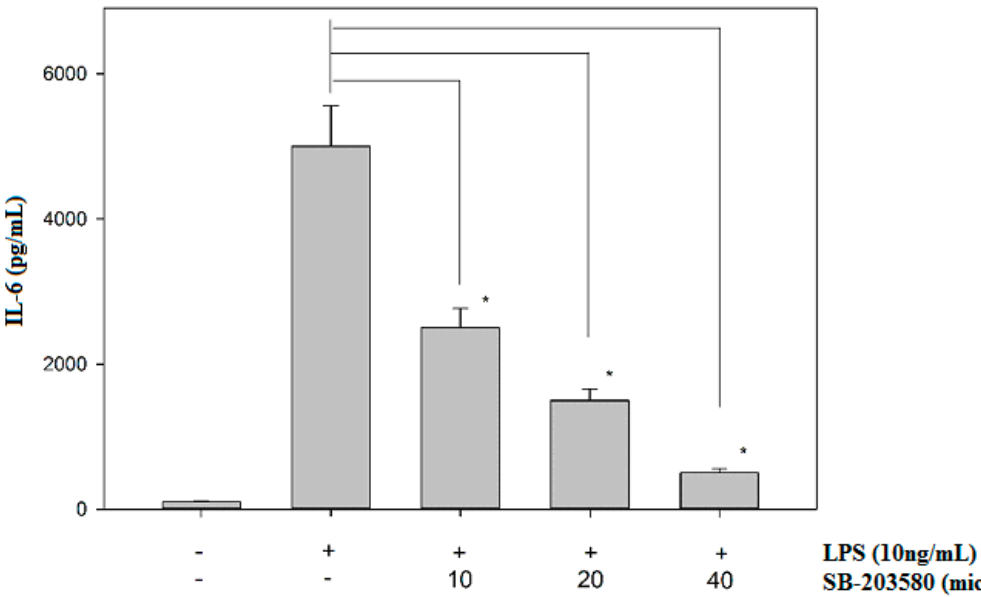
Figure 4. The effect of SB-203580 on the expression of IL-6. IL-6 production was determined at the concentrations of SB-203580 (0, 10, 20 and 40 µM) in LPS-treated, PMA-differentiated THP-1 cells. Data points are shown as the means ± SD ( n = 5). The P value was calculated using one-way ANOVA with the Holm–Sidak method, and the asterisks (*) denote significant differences ( P < 0.05) compared to the LPS control.